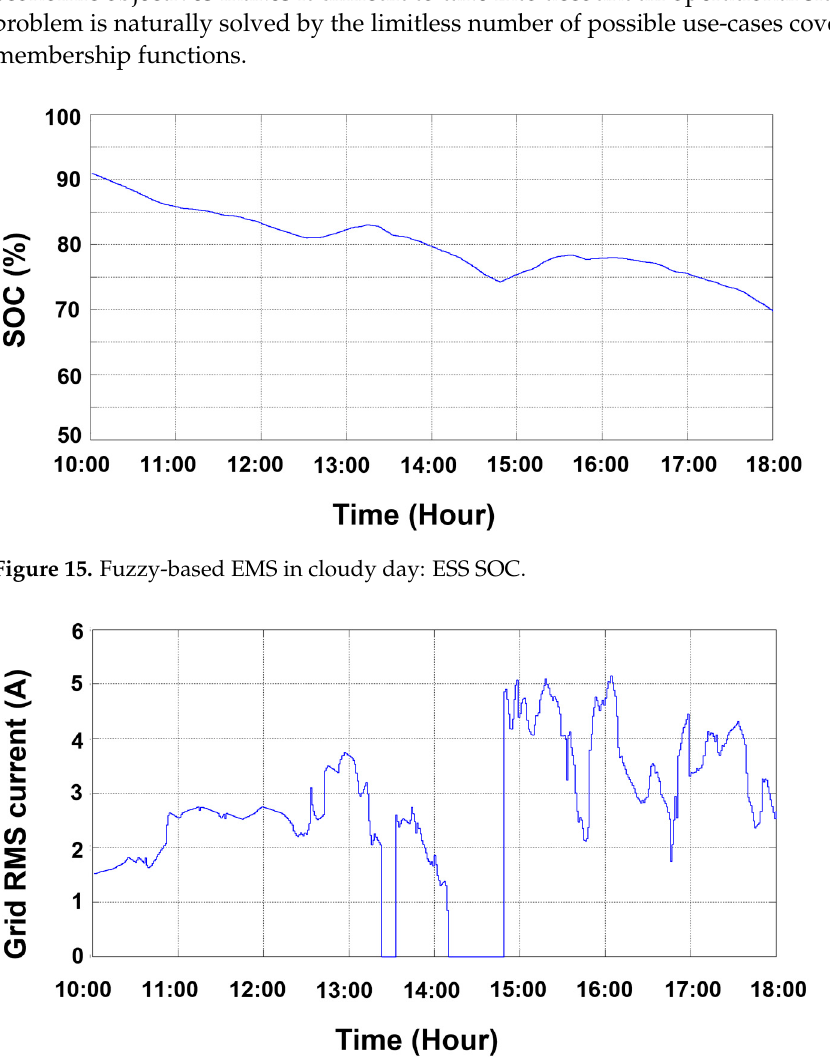
Figure 16. Fuzzy-based EMS in cloudy day: grid RMS current.